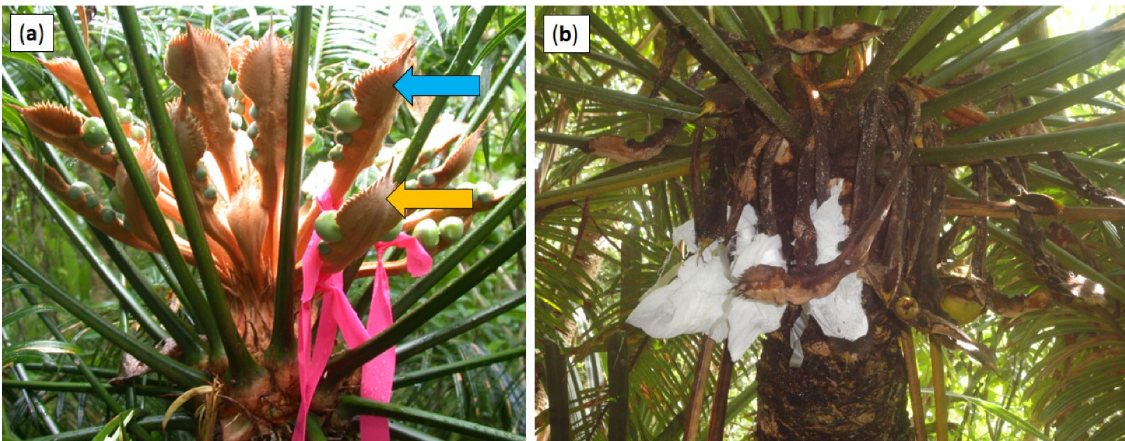
Figure 1. Cycas micronesica megastrobilus appearance for experimental manipulation of Aulacaspis yasumatsui infestations. ( a ) Ten weeks in age with sporophylls marked for experimental inclusion. Yellow arrow shows sporophyll with two developing seeds and two unpollinated ovules. Blue arrow shows sporophyll with two developing seeds and four unpollinated ovules; ( b ) Twelve months in age with individual sporophylls enclosed in polyester fabric to facilitate scale infestation treatments.